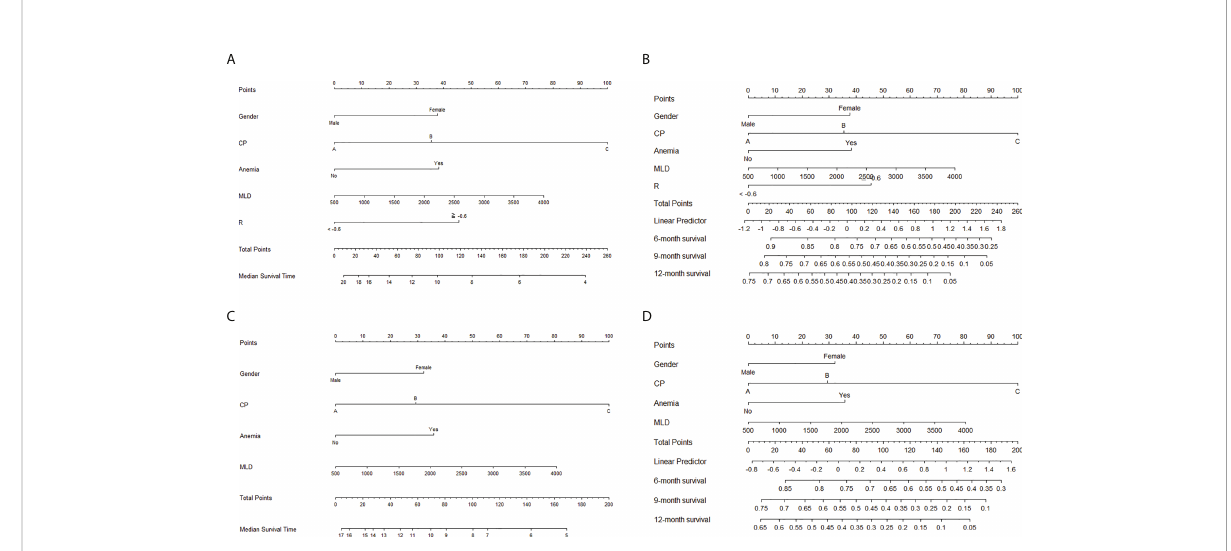
FIGURE 5 Nomograms for the prediction of overall survival. Nomograms with radiomics score, signi fi cant clinical features, and radiation therapy (RT) dosimetric parameters for the prediction of (A) median survival time and (B) 6-, 9-, and 12-month survival rates. Nomograms with selected clinical features and RT dosimetric parameters for the prediction of (C) median survival time and (D) 6-, 9-, and 12-month survival rates.